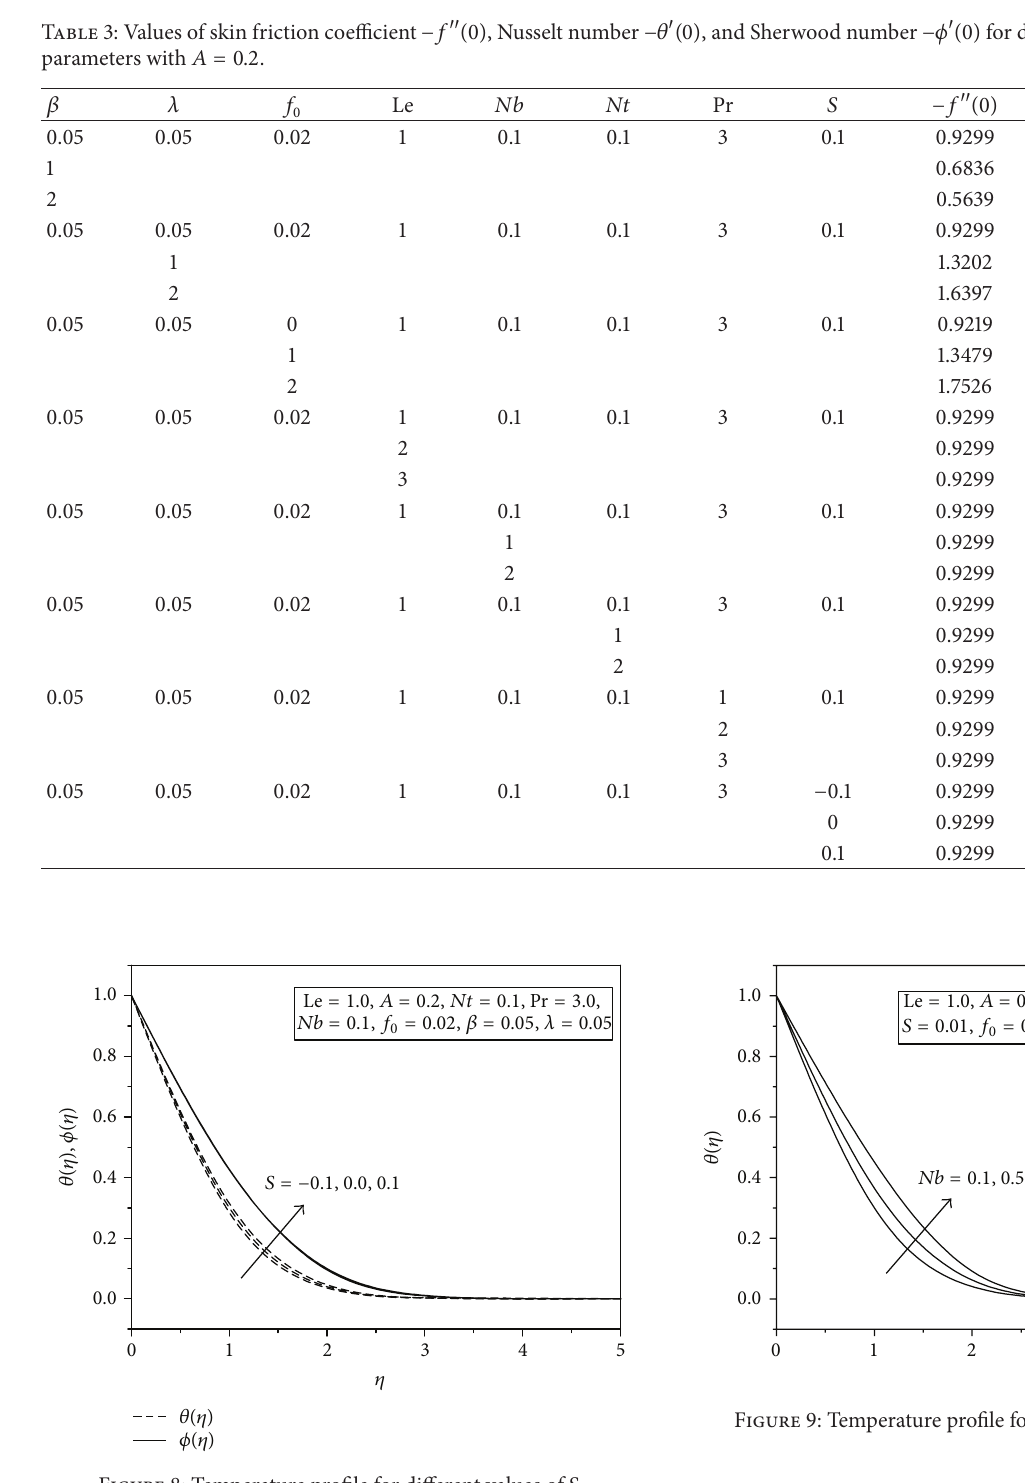
Figure 8: Temperature profile for different values of 𝑆 .